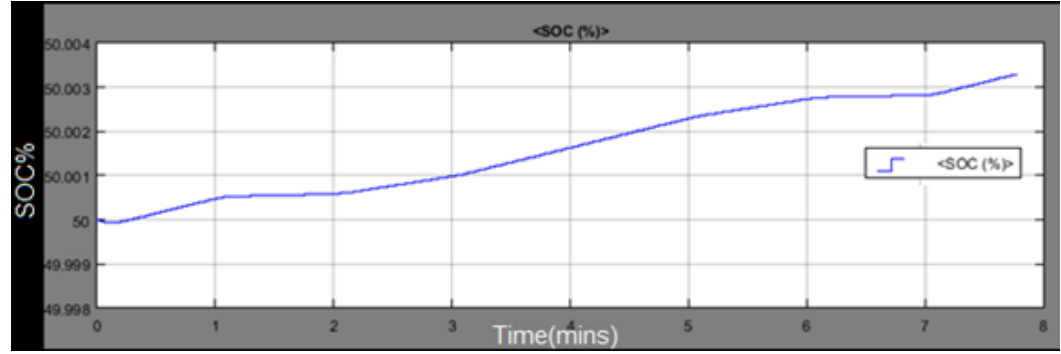
Figure 22. Battery charging mode.